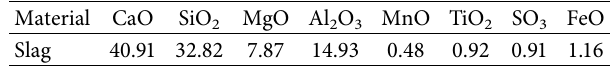
Table 1: Chemical composition of slag